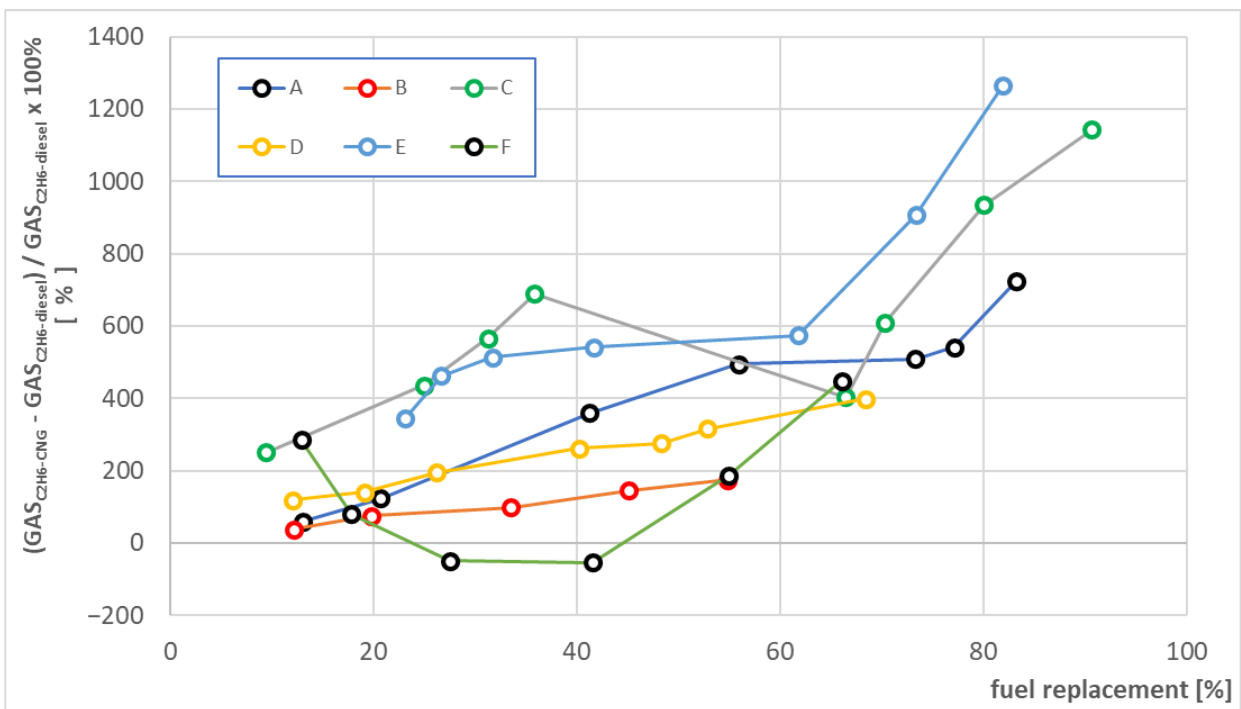
Figure 14. Curves from A to F showing the changes of the emission of ethene as the comparison of exhaust gas temperature noted only in single fuel (diesel) working mode for individual engine operating points, where the rotation speed, power, and torque were constant, as a dual-fuel mode (where engine uses CNG and diesel fuel) replacement function.